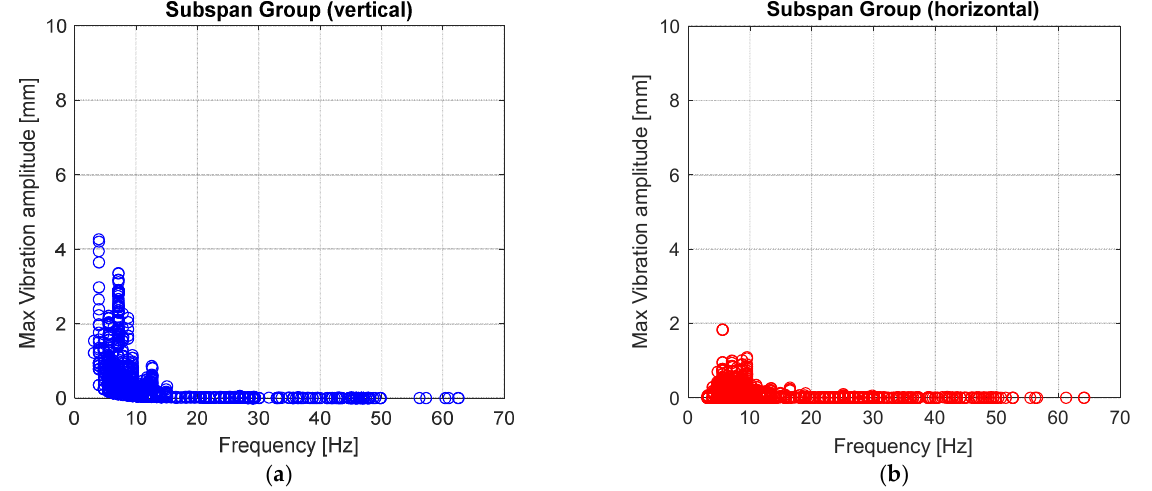
Figure 19. ( a ) Maximum vertical vibration amplitude and ( b ) maximum horizontal vibration amplitudes versus vibration frequency for “Subspan” group.